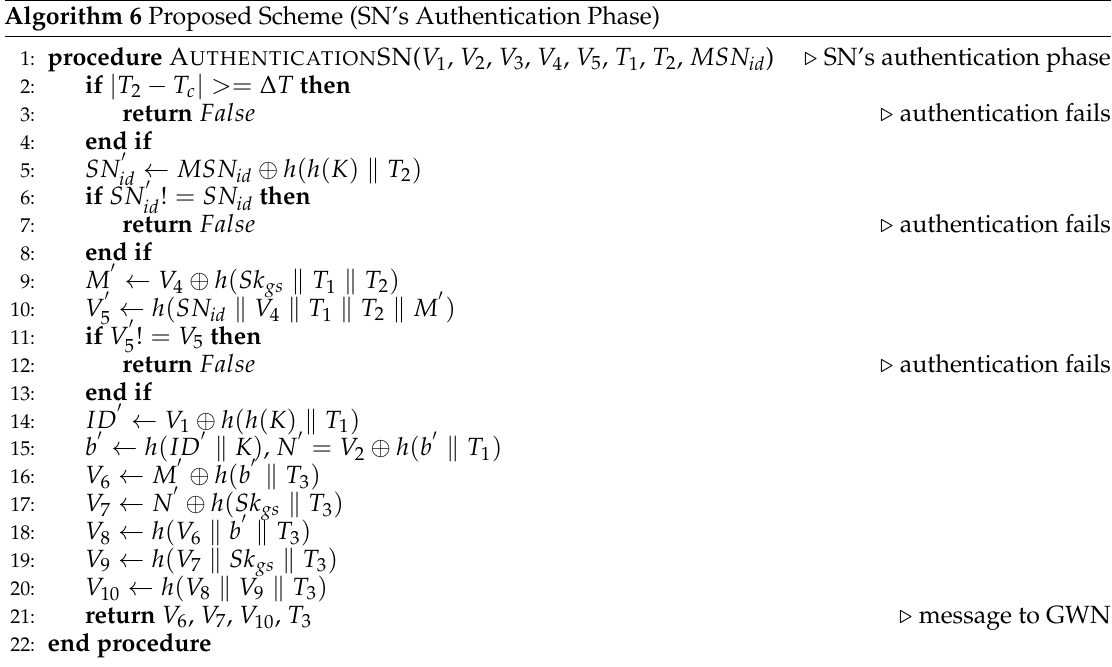
Algorithm 6 Proposed Scheme (SN’s Authentication